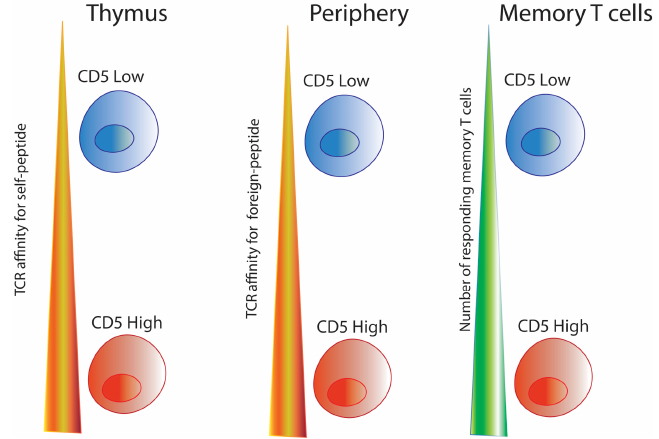
Figure 1. Effects of CD5 on different stages of T cell development. CD5 expression on thymocytes is directly proportional to the signaling intensity of the TCR:self-pMHC interaction. In the periphery, T cells with higher CD5 levels (CD5 hi ) are better responders to foreign-peptide. Long-lived memory cells populations are enriched for CD5 hi T cells